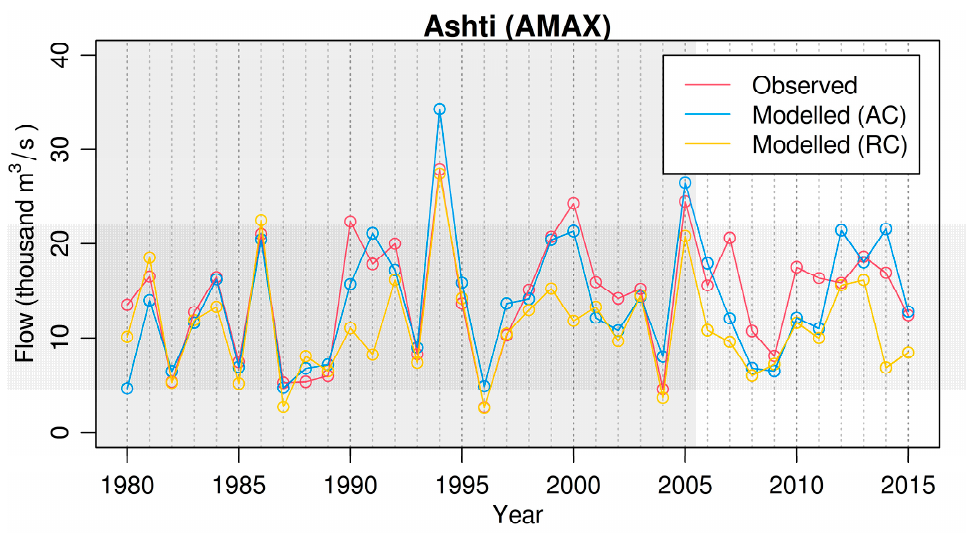
Figure 9. Observed (red line) and modeled AMAX series for Ashti when PDM is optimized to match AMAX from 1983–2006 inclusive (blue line) and optimized to match the whole flow regime from 1983–2006 inclusive (yellow line).